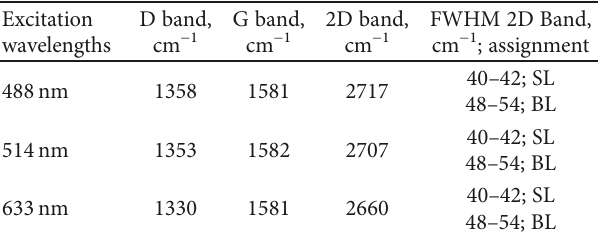
Figure 3: Deconvolution of 2D band identi fi ed as coming from single-layered (a), bilayered (b), and three-layered defected graphene deposited on α C. The spectrum is excited at 633nm laser wavelength. Table 1: Summarized results of Raman spectroscopy examination of as-deposited defected graphene fi lms.